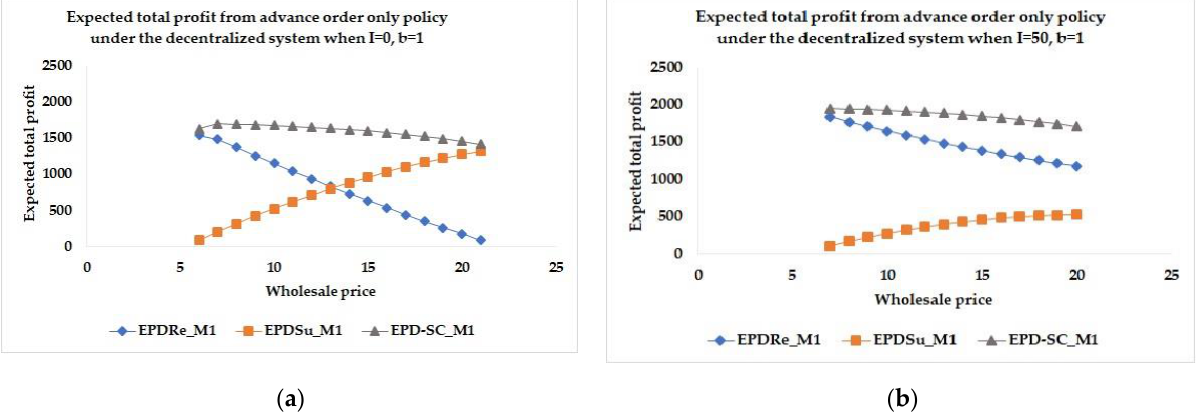
Figure 6. The expected total profit of the retailer, the supplier, and the supply chain of advance order only policy under the decentralized system with different values of w , where b = 1 and ( a ) I 0 = 0; ( b ) I 0 = 50.